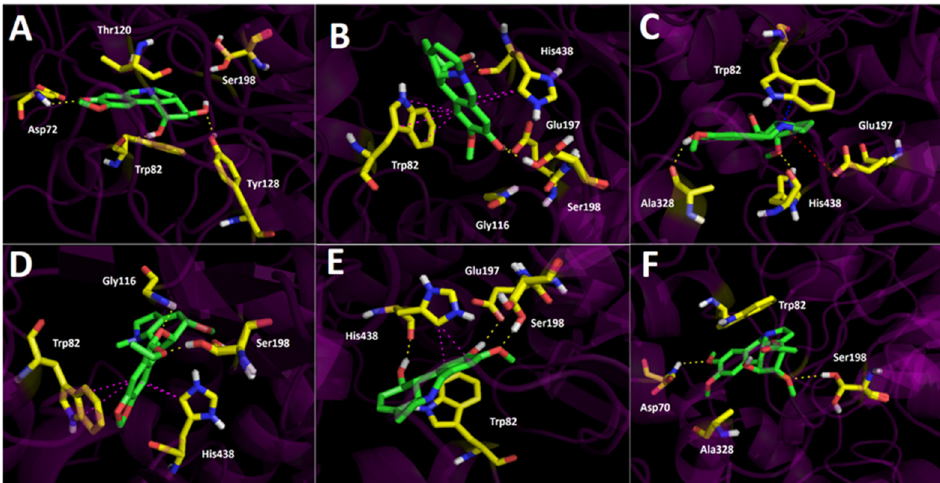
Figure 6. Predicted binding mode and predicted intermolecular interactions of major alkaloids in leaves and bulbs Phycella cyrtanthoides extracts and the residues of the human butyrylcholinesterase ( h BuChE) catalytic site; ( A ) 3-hydroxydihydrocaranine in the catalytic site; ( B ) Kirkine in the catalytic site; ( C ) 10- O -dimethylgalanthine in the catalytic site; ( D ) 2- α -methoxy-6- O -ethyloduline in the catalytic site; ( E ) 10-norpluviine in the catalytic site; ( F ) 3- O -acetylnarcissidine in the catalytic site. Yellow dotted lines indicate hydrogen bond interactions; cyan dotted lines represent π – π interactions; magenta dotted lines represent T-shaped interactions; blue dotted lines indicate π -cation interactions; and red dotted lines indicate salt bridge interactions.